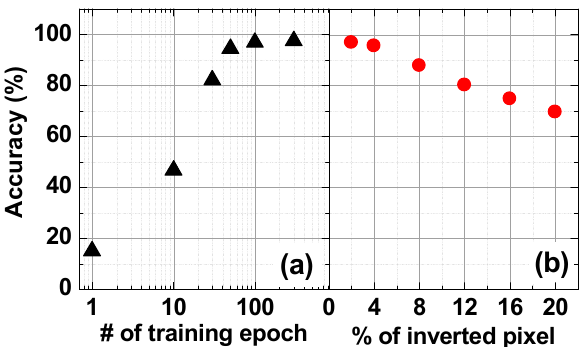
Figure 11. The accuracy of pattern classification after training according to ( a ) the number of training epochs and ( b ) the percentage of inverted pixels.